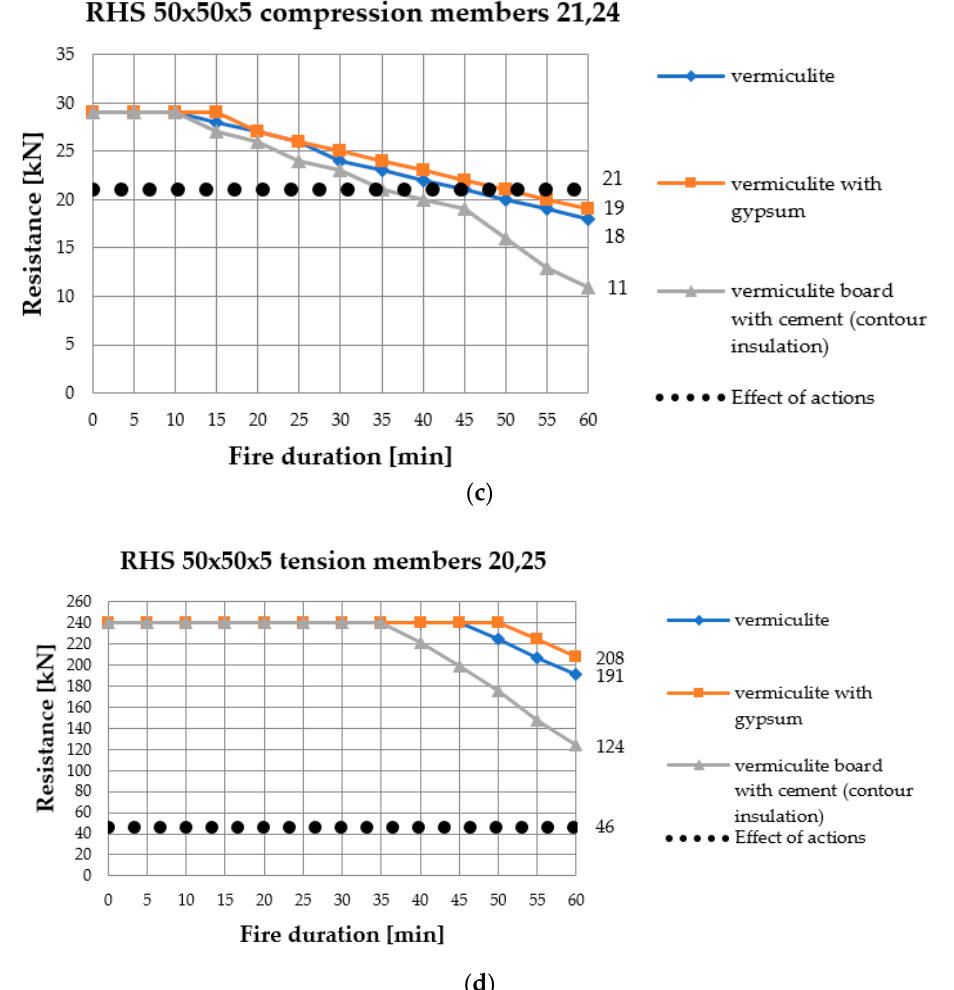
Figure 6. Resistance decrease in truss members under fire conditions (insulation 2 cm): ( a ) I 100 tension members 2 ‐ 5, ( b ) IPE 140 compression members 9,10 , ( c ) RHS 50x50x5 compression members 21,24, ( d ) RHS 50x50x5 tension members 20,25.